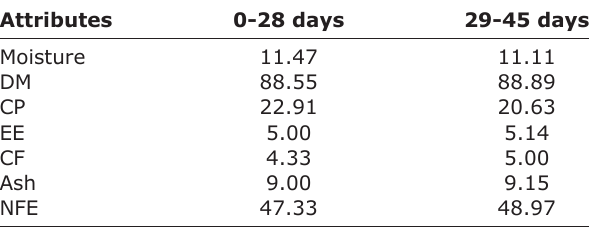
Table-3: Chemical composition (% DM basis) of experimental diets in different growth phases of broiler chicks.